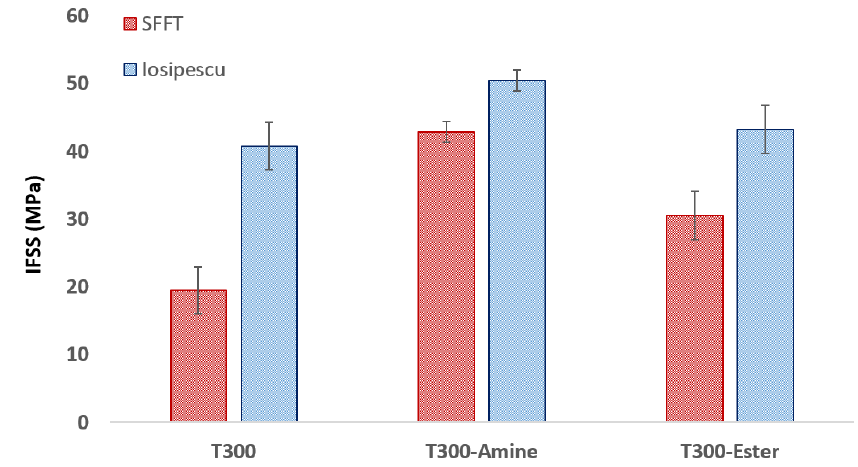
Figure 8. SFFT and Iosipescu IFSS results of T300, T300-Amine and T300-Ester fibers.